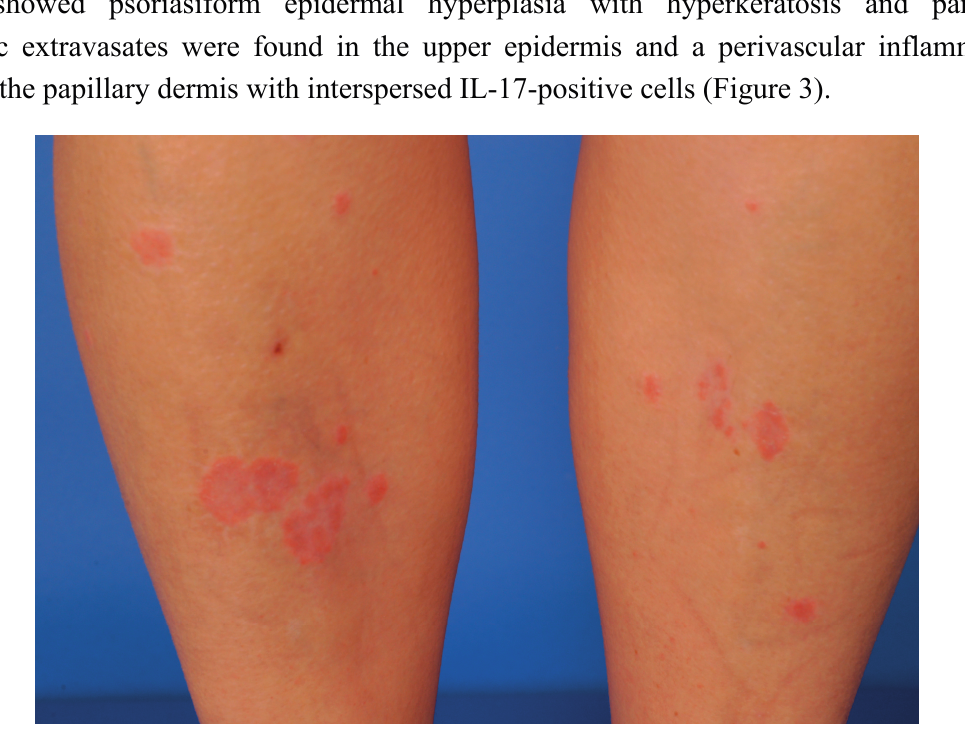
Figure 2. Scaly erythematous plaques occurring on the lower extremity 6 months after initiation of interferon- β (IFN- β